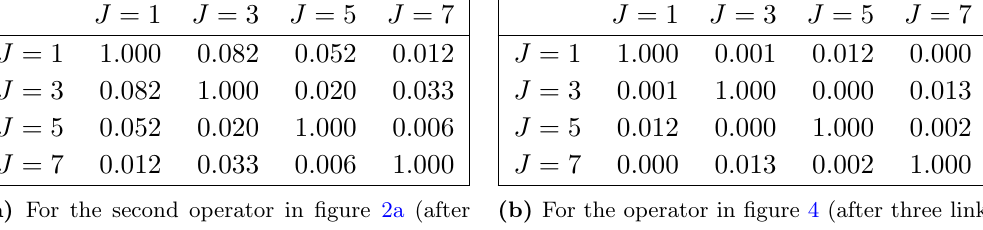
Table 2. Examples of absolute values of overlaps of J ++ components in the E representation of Z 4 .